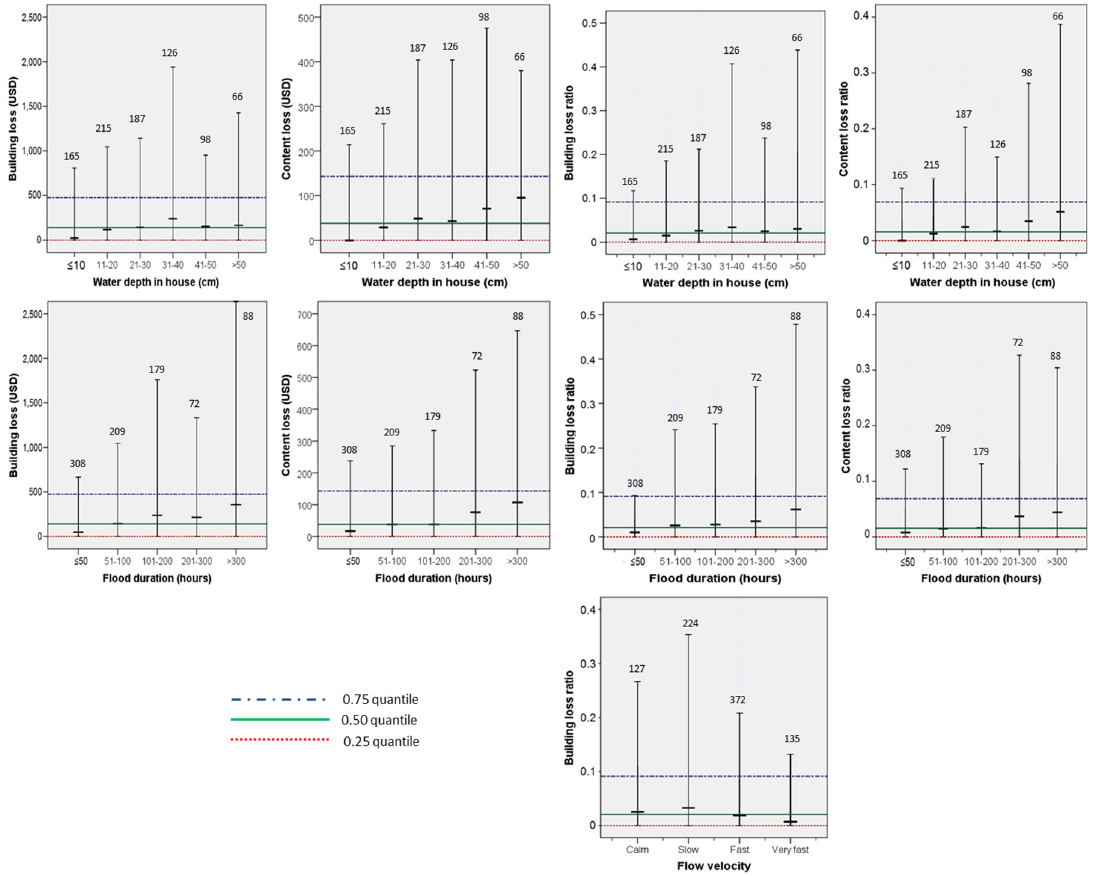
Figure 4. The relation between building loss, content loss, the building loss ratio and the content loss ration with water depth, duration and flood velocity. The horizontal lines represent the 0.25, 0.5 and 0.75 quantiles of the loss ratios of the total dataset.